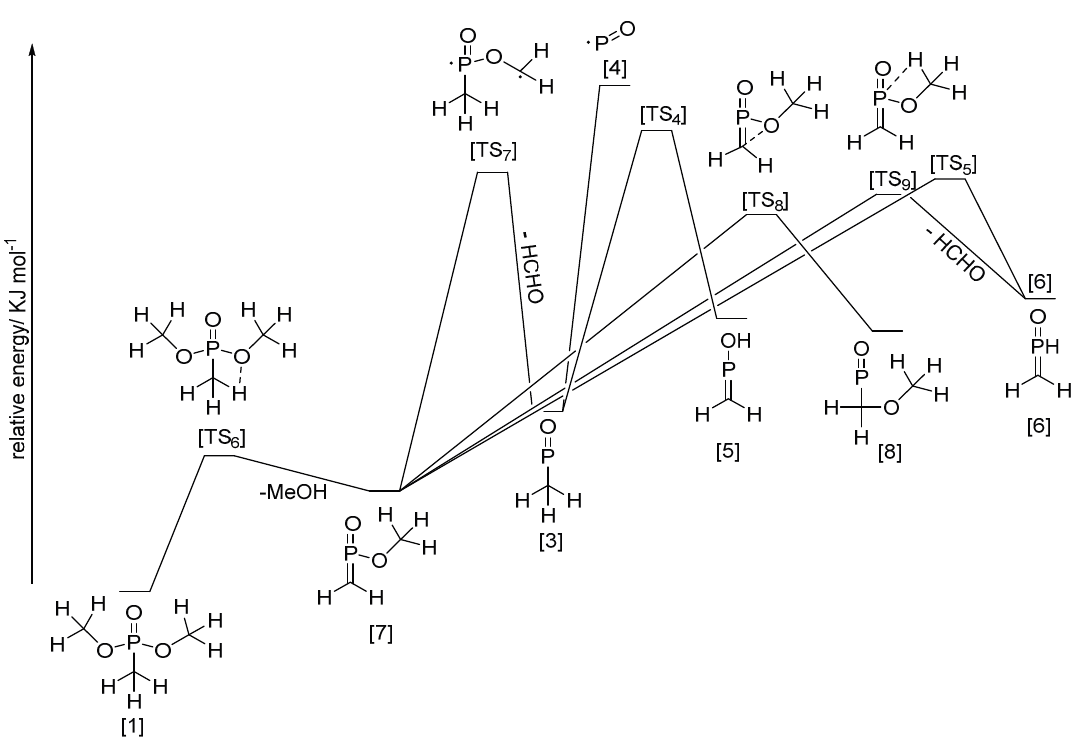
Figure 5. CBS-QB3 energy diagram for thermal decomposition of DMMP (pathway